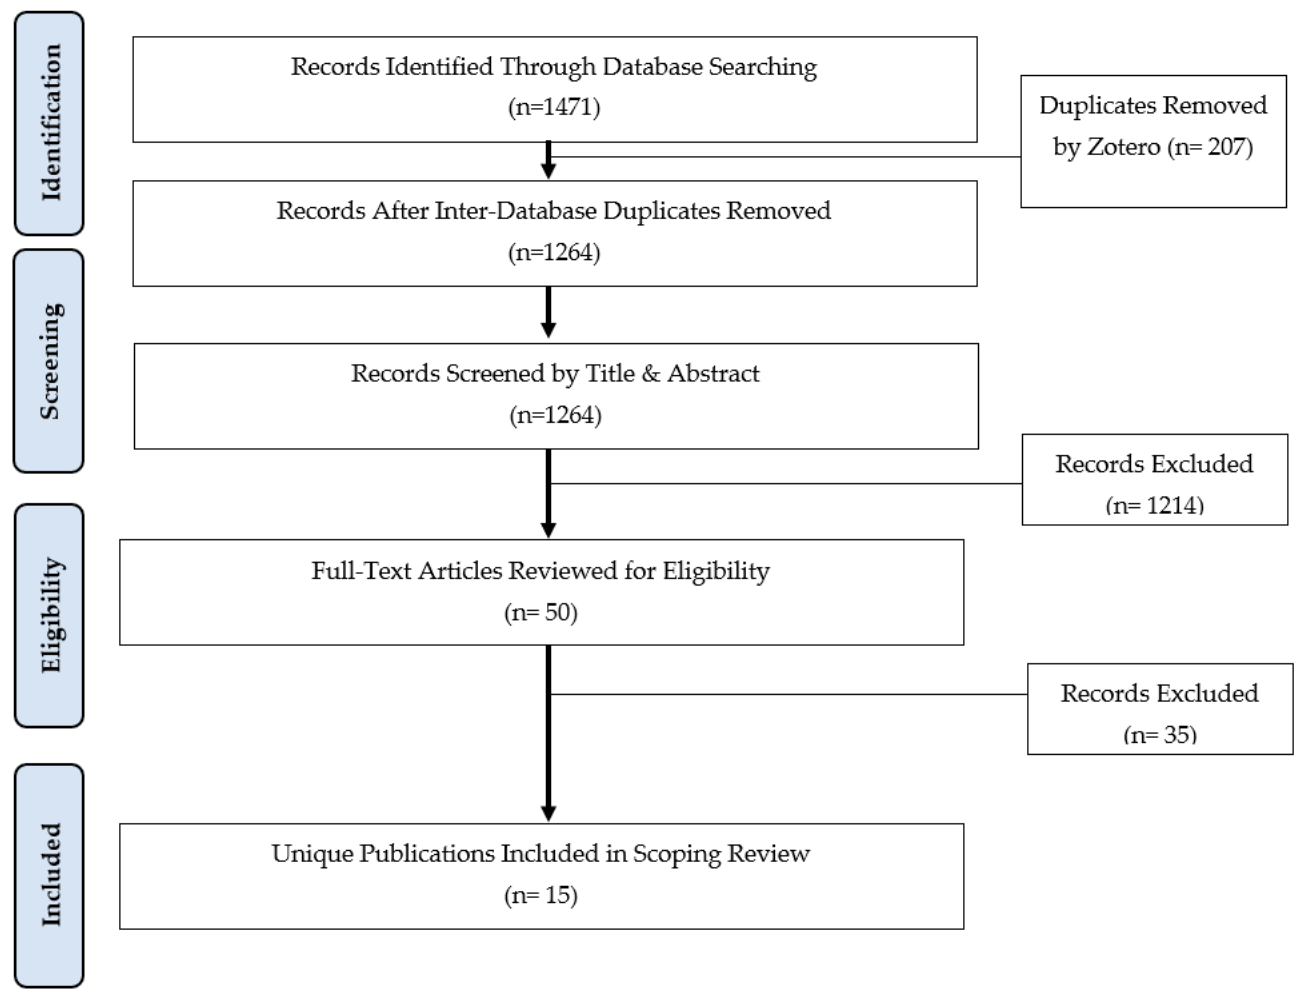
Figure 1. PRISMA flowchart.